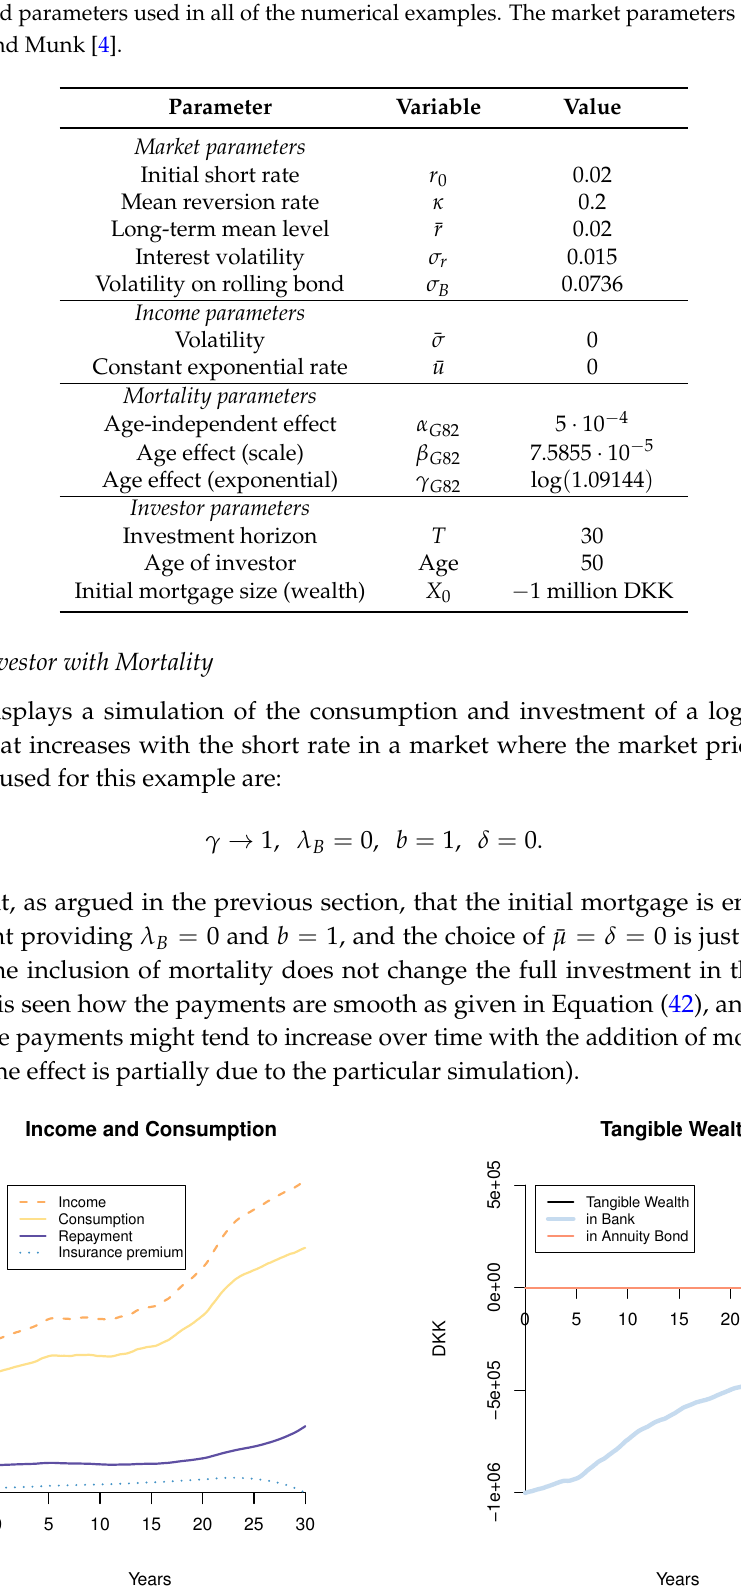
Figure 1. Log-investor with interest- and time-preference-matching labor income and with mortality